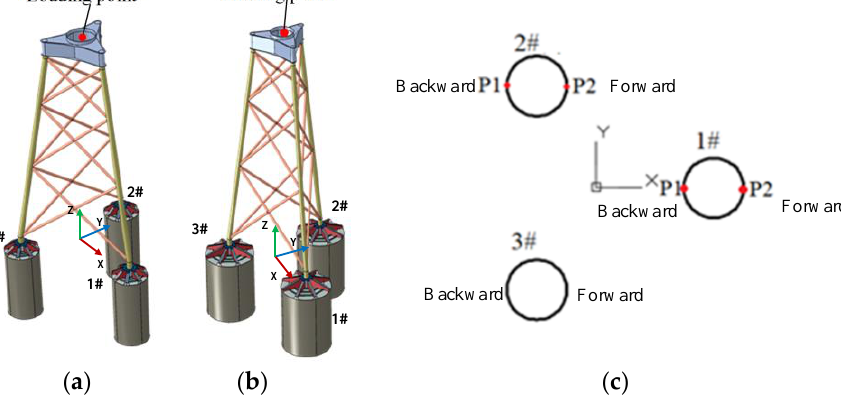
Figure 1. Models of the TSPJF and TBJF. ( a ) TSPJF, ( b ) TBJF, and ( c ) coordinates and bucket num- ber.